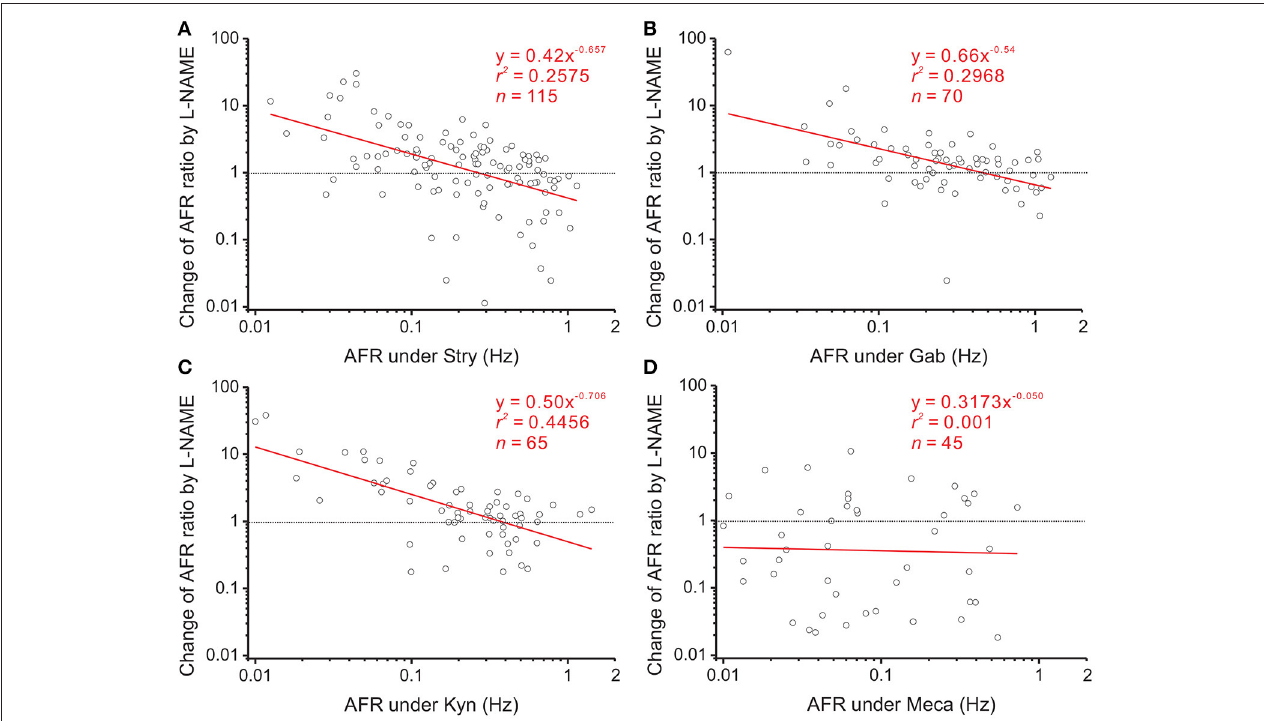
FIGURE 5 | Effects of blocking various endogenous receptor activities on NO-mediated plFM. The log-log plots show the data obtained from bath applications of 100 µ M L-NAME after a pretreatment of 2 µ M Stry (A) , 20 µ M Gab (B) , 400 µ M Kyn (C), or 1 µ M Meca (D) . Effects of these pretreatments on firing activities were shown in Figure 4 . The plFM induced by L-NAME persisted with the pretreatment of Stry, Gab or Kyn. With the pretreatment of Meca, applications of L-NAME did not cause the plFM. Significance of regression: P < 0.00001 in (A–C) and P = 0.8385 in (D) . CI b : (A) − 0.896 to − 0.419, (B) − 0.771 to − 0.309, (C) − 0.934 to − 0.478, and (D) − 0.594 to 0.495.